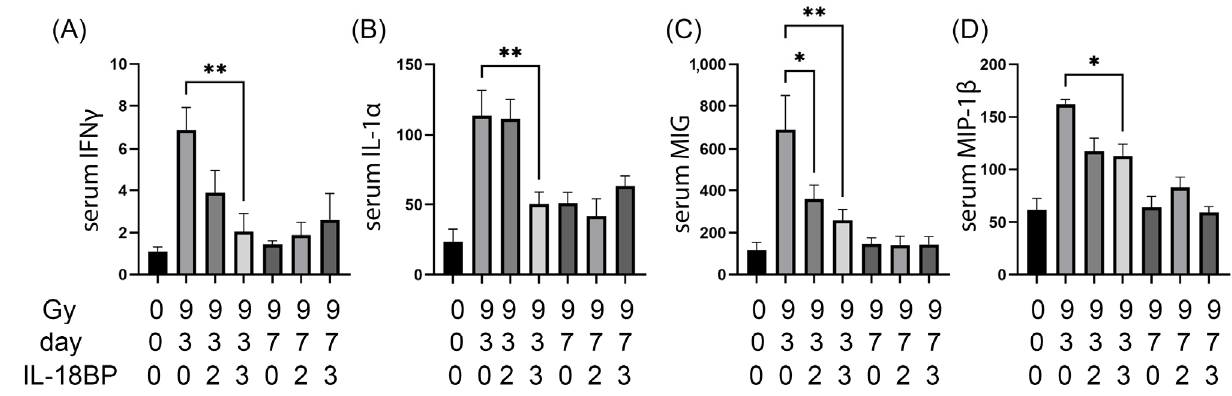
3.5. Serum Cytokines That Were Significantly Changed by rhIL-18BP Treatment after 9.0 Gy TBI rhIL-18BP treatment significantly decreased 4 out of the 44 serum cytokines at d3 after 9.0 Gy TBI, including IFN γ , IL-1 α , MIG and MIP-1 β (Figure 4). The effect of rhIL-18BP treatment was dose- and time-dependent. 3 mg/kg rhIL-18BP treatment significantly decreased the serum levels of IFN γ , IL-1 α , MIP-1 β at d3 only (Figure 4 A,B,D), while both 2 and 3 mg/kg rhIL-18BP treatment significantly decreased serum MIG levels at d3 post TBI (Figure 4C).